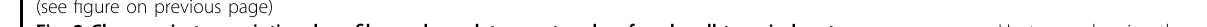
Fig. 2 Changes in transcriptional pro fi les and regulatory networks of each cell type in keratoconus corneas. a Heatmaps showing the distribution of up-regulated (red) and down-regulated (blue) DEGs in each cell type in KC samples compared with those in Ctrl samples, and genes not differentially expressed are in gray. Rows represent genes and columns denote cell types. The upper part within dashed boxes indicates the DEGs shared by at least two cell types, while the lower panel indicated the unique DEGs for each cell type. The numbers of DEGs are annotated on the plots. b Representative GO terms of up-regulated (red) and down-regulated (blue) DEGs for each cell type. c Cell type-speci fi c gene expression pro fi le of keratoconus-associated genes. The value for each gene is the row-scaled Z score. d The expression changes of representative collagen family members, ECM and matrix metalloproteinase-related genes between KC and Ctrl samples in each cell type. e Heatmap showing TF expression discrepancy between Ctrl and KC in each cell type. f Regulatory network visualizing TFs identi fi ed in CSCs and their target genes predicted by SCENIC. TFs are colored in light blue and representative target genes down-regulated in keratoconus are in dark blue. The node sizes are positively correlated to the edge counts for each node. g Representative GO enrichment terms for genes targeted by TFs identi fi ed in